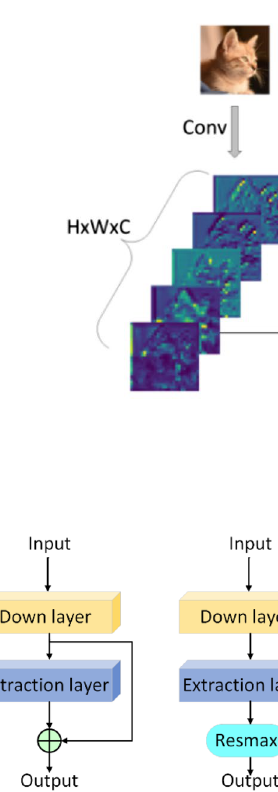
Fig. 6 Resmax structure